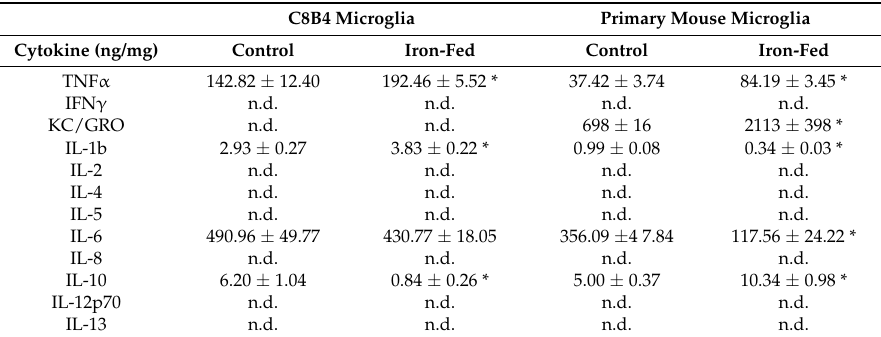
Table 1. Cytokine released into conditioned medium.